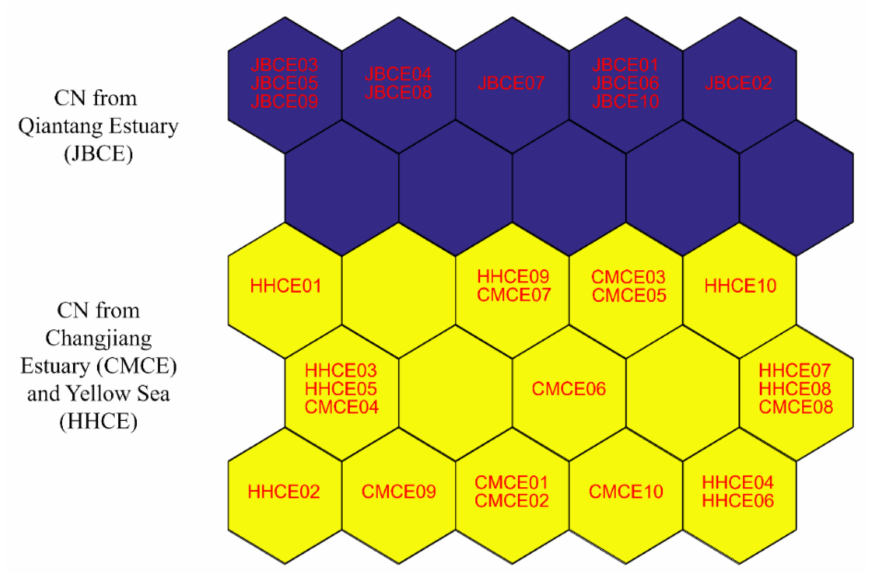
Figure 6. Self-organizing map (SOM) analysis of Coilia nasus from the Nantong coastal area of the Yellow Sea (HHCE), the Changjiang estuary near the Jiuduansha Shoal (CMCE), and the Jiubao bridge waters in the Qiantang estuary (JBCE). Those of HHCE and CMCE were mixed in yellow cells, while those of JBCE were independent of the others in blue